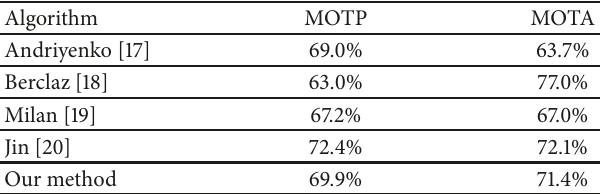
Table 1: The comparison results of multitarget